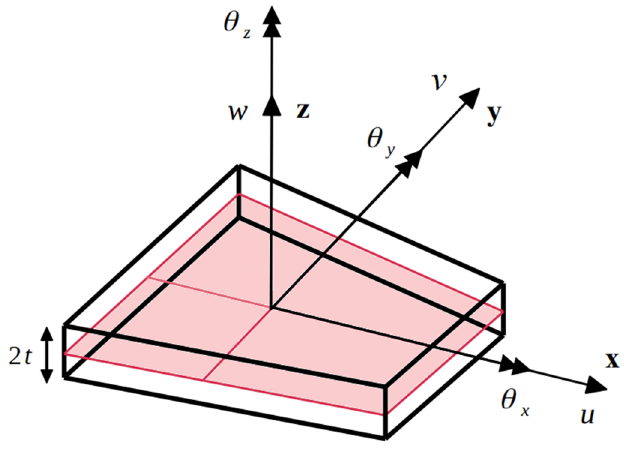
Figure 1. Sign conventions used for the kinematic variables of a 4-node quadrilateral inverse ele- ment.